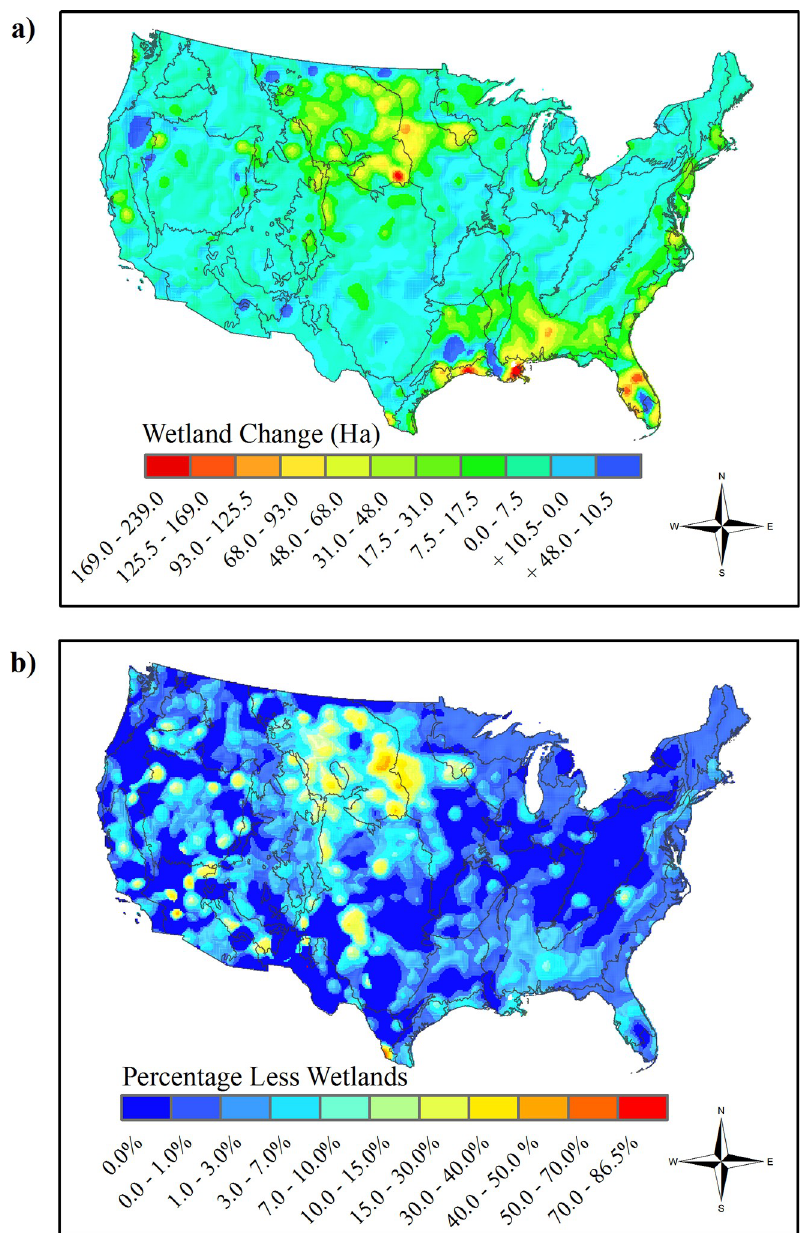
Fig 5. Wetland change in the conterminous U.S. 2001 to 2011. Transition per 100 km 2 pixel of woody and emergent herbaceous wetlands to other land covers between the National Land Cover Database 2001 and 2011. The highest total hectare change ( a ) occurred in the northern Great Plains, Southeastern and Mississippi Alluvial Plains. Greatest percentage wetland change ( b ) occurred in the northern Great Plains and areas of the desert southwest. There was a reduction of approximately 481,000 ha of wetlands over the ten-year period. Boundary lines are the level II ecoregions of the conterminous U.S.